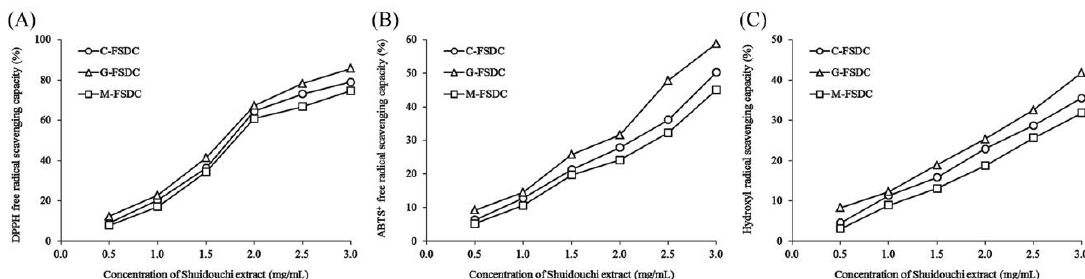
Figure 10. DPPH ( A ), ABTS + ( B ), and hydroxyl ( C ) free radical scavenging capacity of Shuidouchi fermented in different containers. C-FSDC: Ceramic container used for Shuidouchi fermentation; G-FSDC: Glass container used for Shuidouchi fermentation; M-FSDC: Metal container used for Shuidouchi fermentation. Table 9. DPPH (A), ABTS + (B), and hydroxyl (C) free radical scavenging capacity of Shuidouchi fermentated in different containers. Type Group Linear Regression Equation IC 50